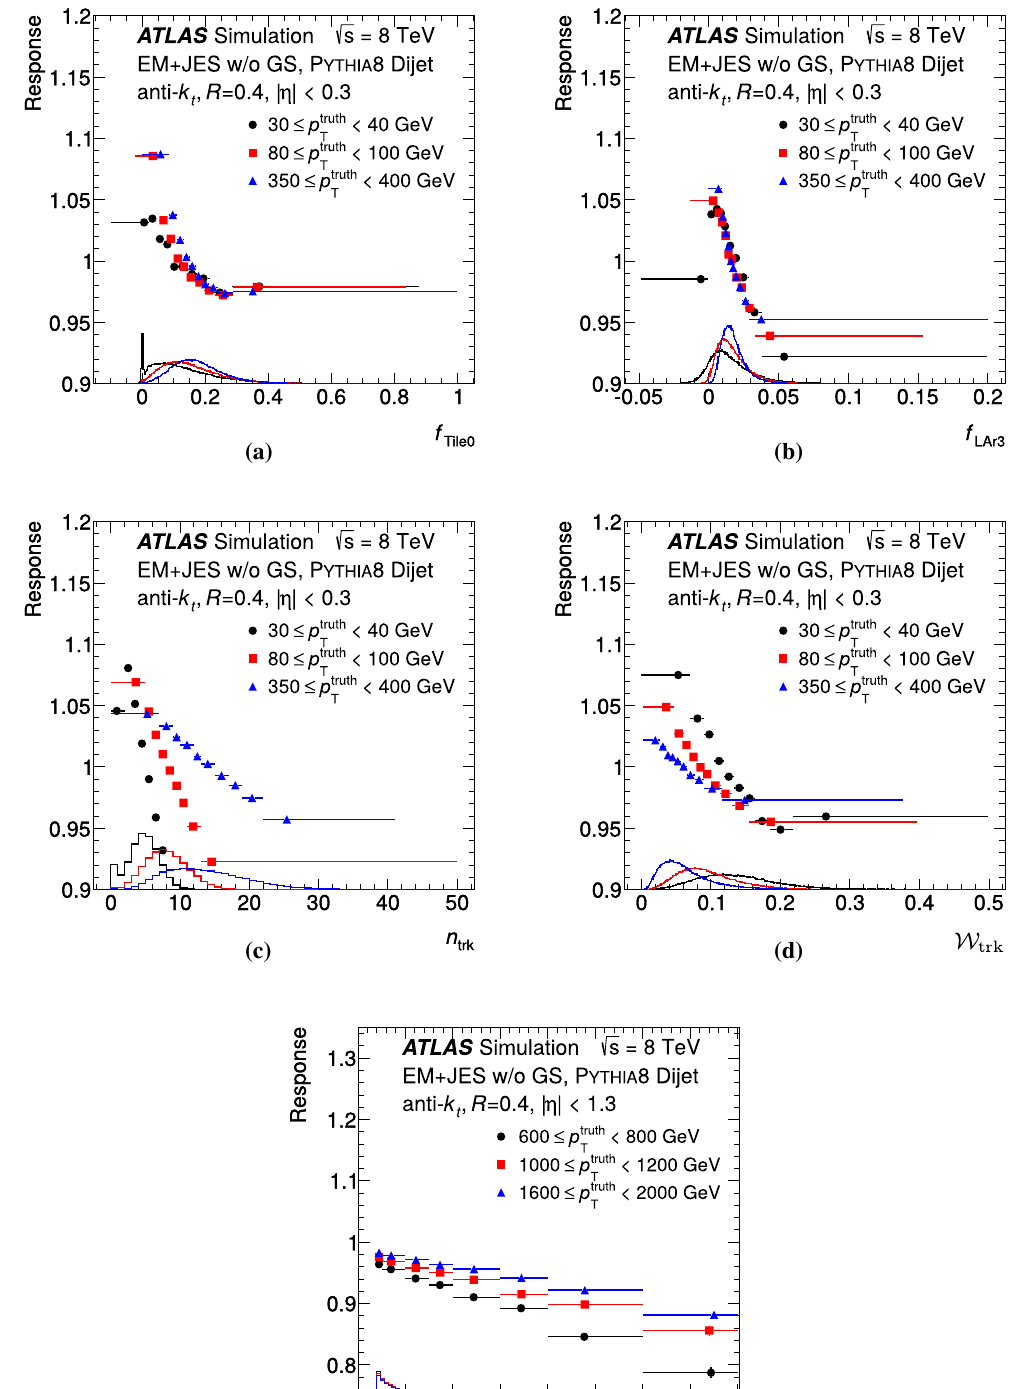
Fig. 8 Jet p T response as a function of f Tile0 , f LAr3 , n trk , W trk and N segments for jets with | η det | < 0 . 3 ( | η det | < 1 . 3 for N segments ) in dif- ranges. All jets are reconstructed with anti- k t R = 0 . 4 and ferent p truth T calibrated with the EM+JES scheme without global sequential cor-